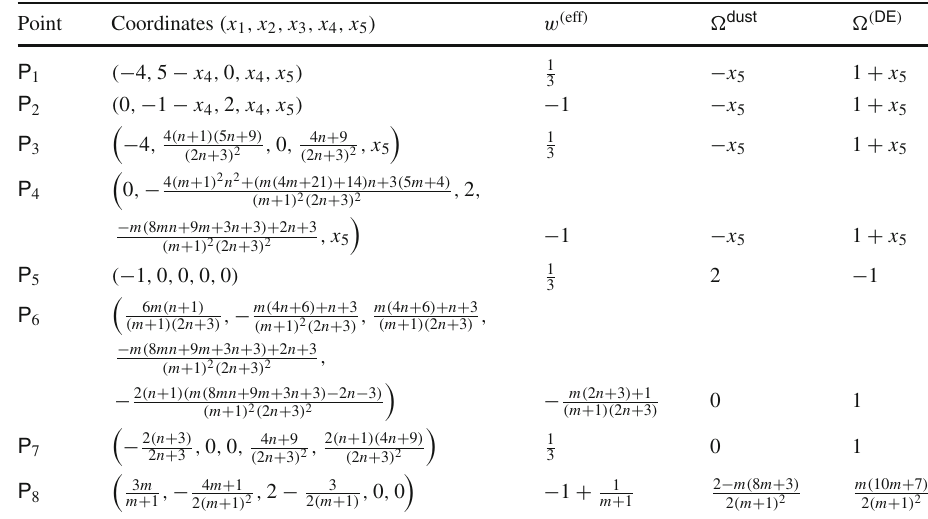
Table 1 The fixed points solutions of f ( R , T ) = g ( R ) + h ( − T )